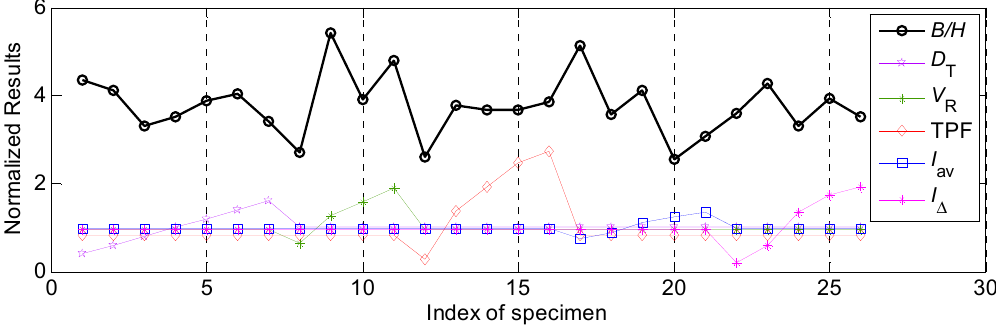
Figure 10. The normalized results of various process parameters and weld forming factor.